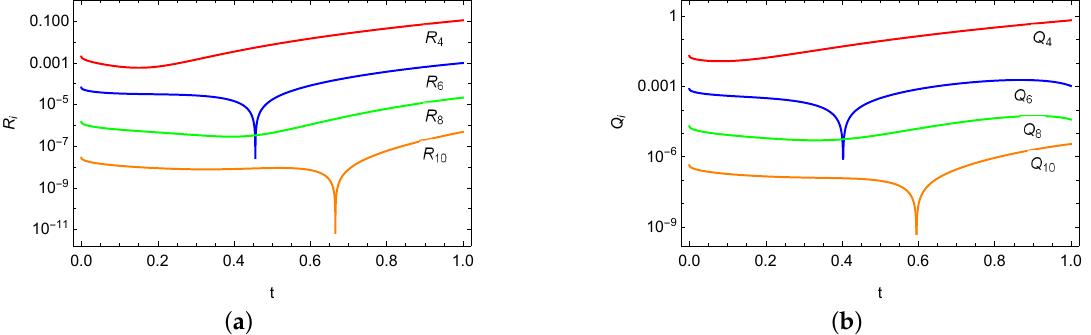
Figure 5. The presentation of convergence (on a logarithmic scale): ( a ) temperature distribution, where R i ( t ) = | (cid:98) θ i ( t ) − (cid:98) θ i − 1 ( t ) | , ( b ) heat flux, where Q i ( t ) = | (cid:98) q i ( t ) − (cid:98) q i − 1 ( t ) | .